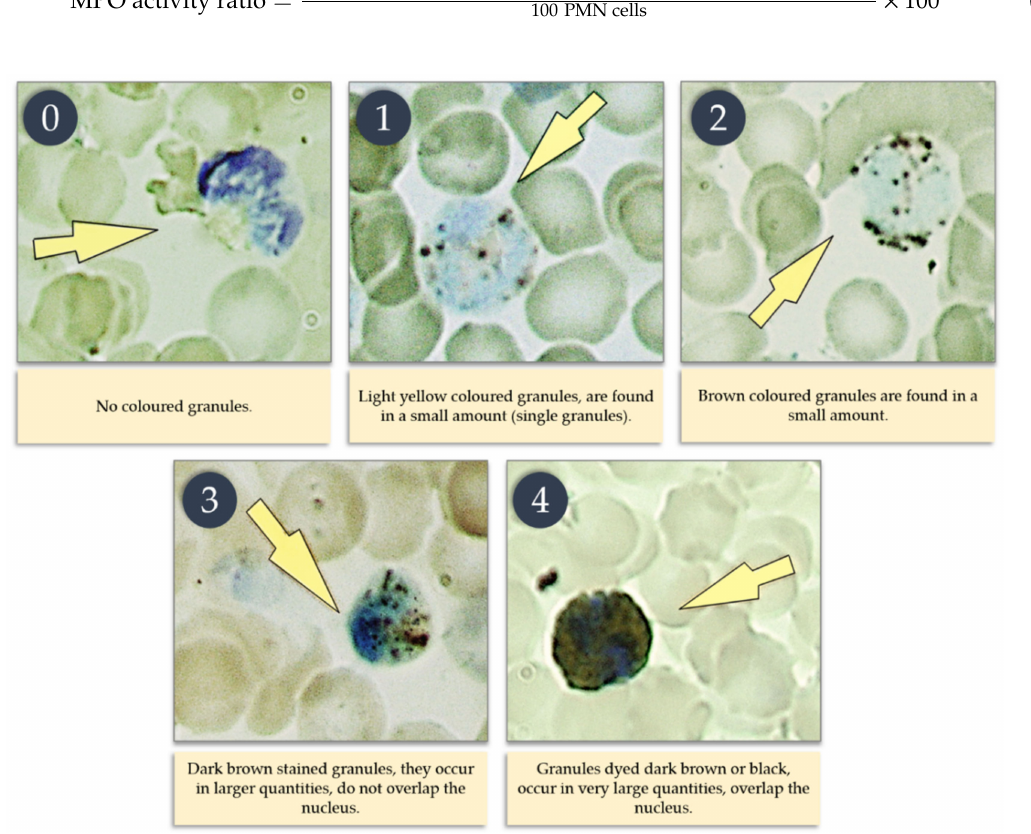
Figure 1. Scale showing the intensity of granule staining in PMN